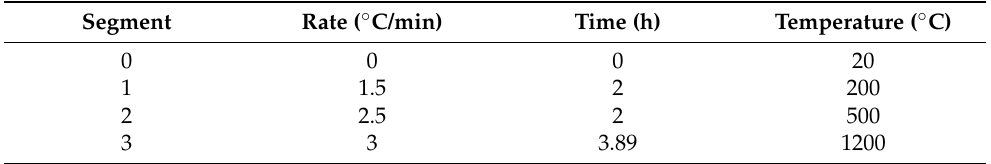
Figure 2. Pictures of ceramic tiles ( left : freshly compacted; right : fired). Table 3. The firing